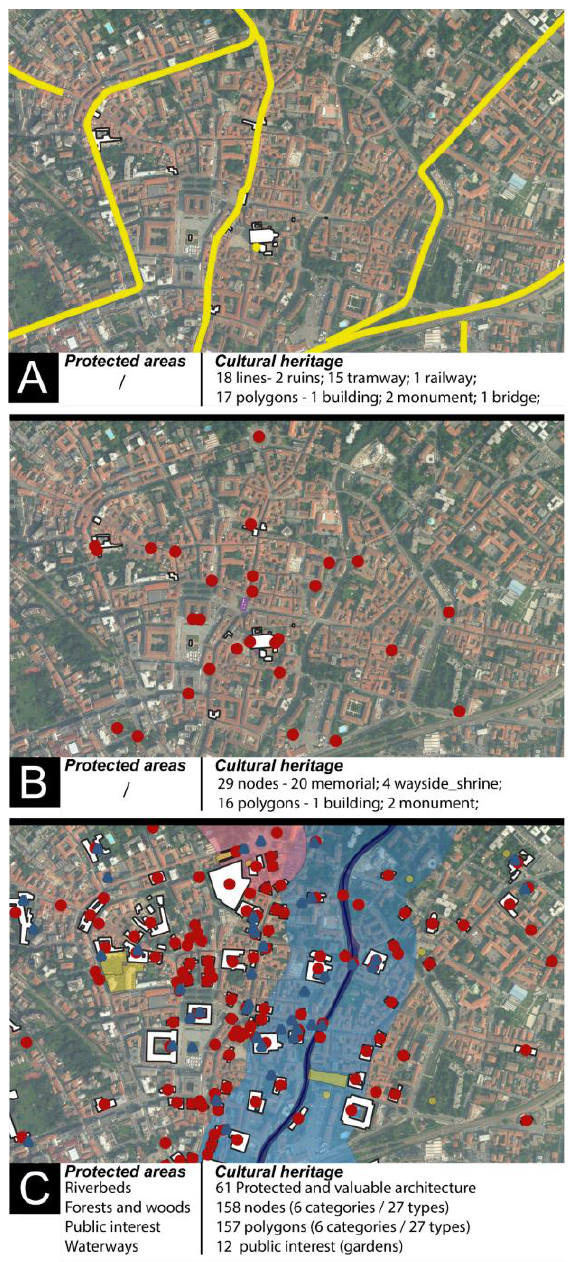
Figure 1. Comparison of the quantity and quality of open data about cultural heritage from A: OSM data downloaded with Overpass turbo; B: OSM data downloaded with QuickOSM; C: Data from Lombardian Geoportal. Background: WMS Orthophoto 2015 (source: Lombardian Geoportal).